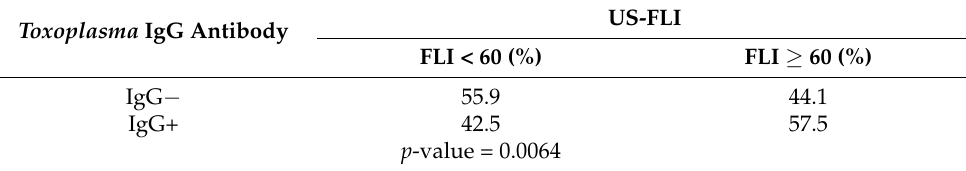
Table 10. US-FLI per T. gondii (IgG+/IgG −